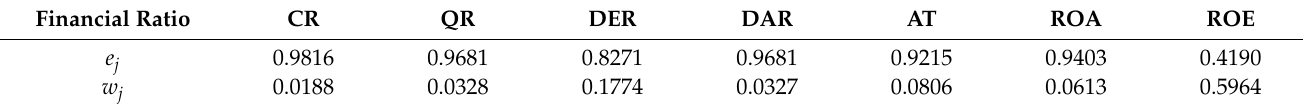
Table 5. The information entropy ( e j ) and the entropy weight ( w j ) of the financial ratios.